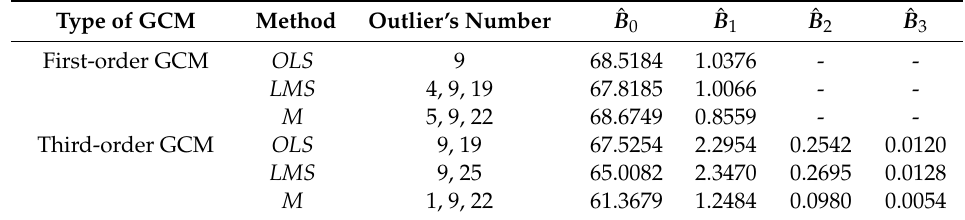
Table 2. Parameter estimations and outlier detections with ordinary least squares ( OLS) , least median square ( LMS) , and M estimators.